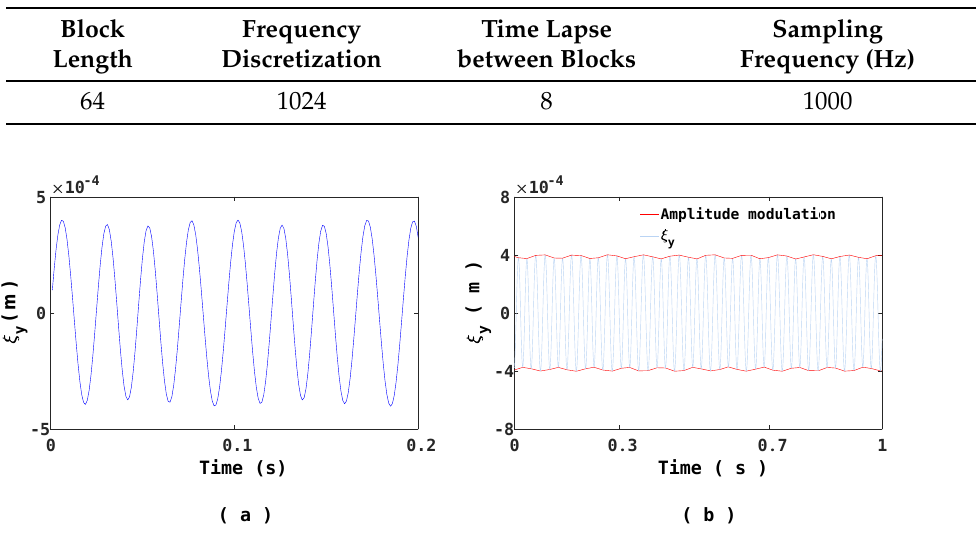
Table 2. Spectrogram parameters.